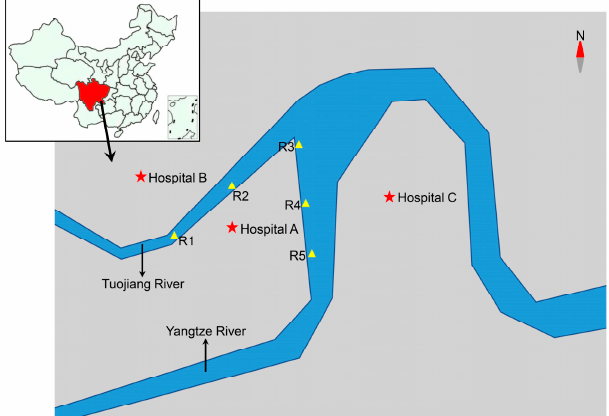
Figure 1. Schematic diagram of sampling sites of hospital sewage and river water, Luzhou City, Sichuan, China, 2019. The sampling sites of hospital sewage are indicated by stars. R1–R5: sampling sites of river water.